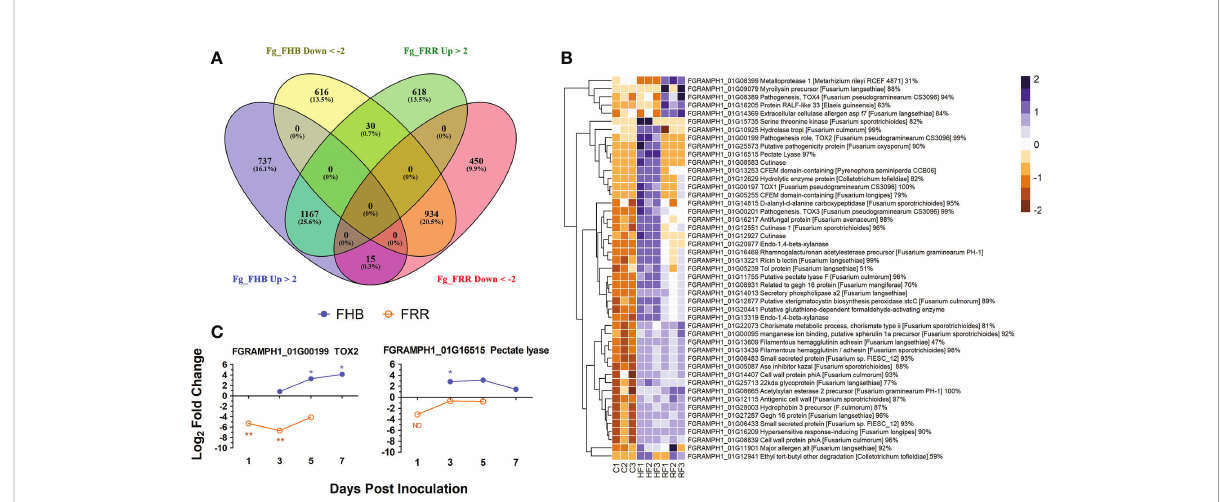
FIGURE 7 The differential expression of F. graminearum genes between FHB and FRR. (A) A summary of all signi fi cantly upregulated or downregulated F. graminearum genes in response to FHB and FRR. The threshold of -2 ≤ x ≥ 2 Log-fold change and p-adj < 0.05 was applied to all genes. (B) The most upregulated F. graminearum predicted-effector genes in FHB and FRR that have predicted functions. These genes have an expression of Log-fold increase ≥ 3 in FHB and/or FRR. Three biological replicates for each of the three treatments are displayed as columns. Control Treatment (C1-3) is the average normalised gene counts (two values per column/biological replicate) of in vitro treatments (four-day- old samples grown in Czapek-Dox Liquid media). The same in vitro sample was analysed separately (DESeq) with the FHB and FRR samples. (C) Expression time-course of two differentially expressed F. graminearum genes (FGRAMPH1_01G00199 (TOX2) and FGRAMPH1_01G16515 (pectate lyase)) in FHB and FRR identi fi ed in (B) Blue lines with solid circles denote FHB and orange lines with open circles denote FRR. Log values presented are calculated by comparing infected tissue against mock-inoculated treatments. The housekeeping gene GzUBH was used. Level of signi fi cance relative to the mock-control: Cq t-test *p < 0.05, **p < 0.01. “ ND ” (Not enough Data) denotes no statistical comparison due to insuf fi cient data points in treatment. Bd ( B. distachyon ), Up (Upregulated), Down (Downregulated), FRR (Fusarium Root Rot), FHB (Fusarium Head Blight). C ( in vitro control respective to FHB and FRR), HF (Head-FHB fungus), RF (Root-FRR